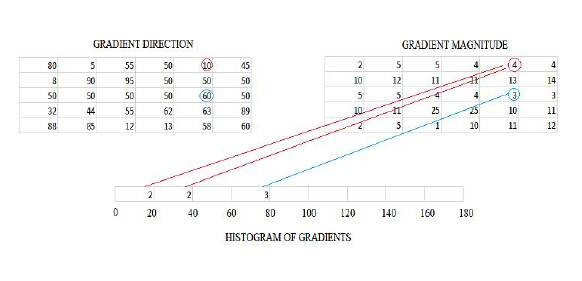
Figure 6: Histogram of Gradients. Calculation of each pixel is weighted that is magnitude of 10 degree is shared equally by 0 and 20 therefore the magnitude in HoG is increased in both 0 and 20 bins.